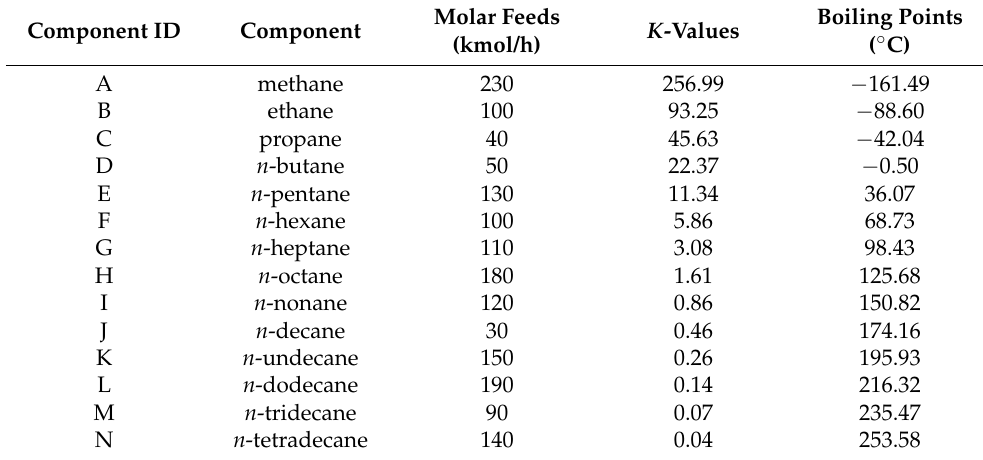
Table 1. Properties of the fourteen-component